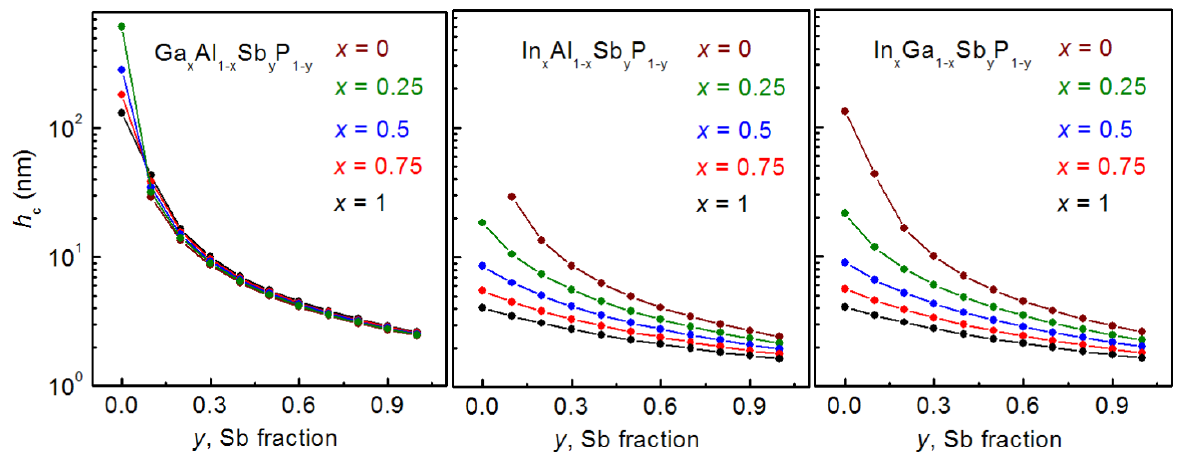
Figure 8. Dependences of h c on the Sb fraction ( y ) for different contents of group III element ( x )